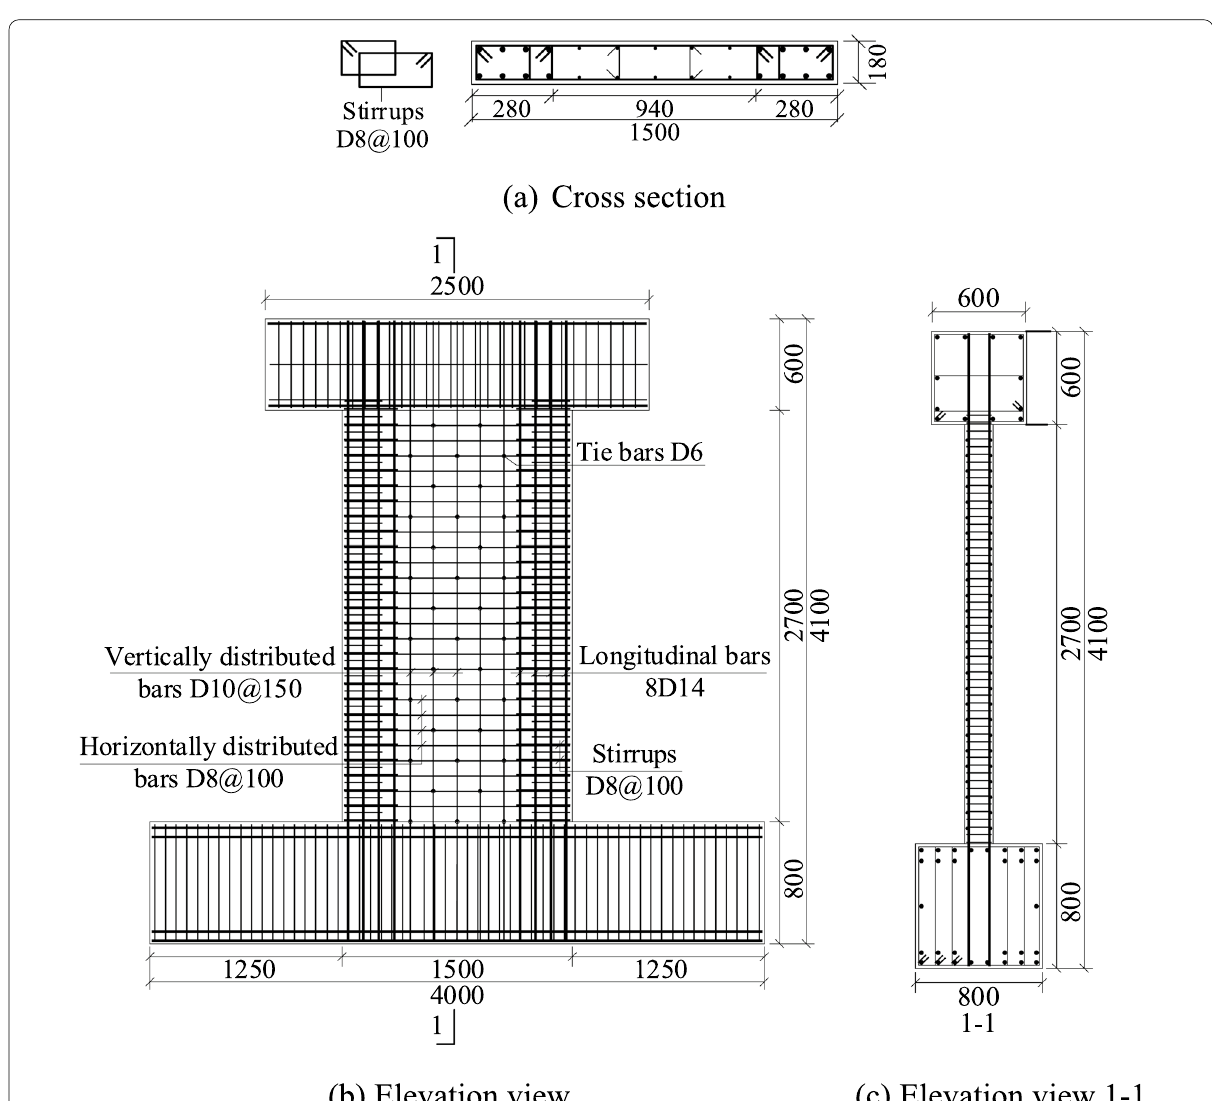
Fig. 1 Geometry and reinforcement of specimens (units: mm).